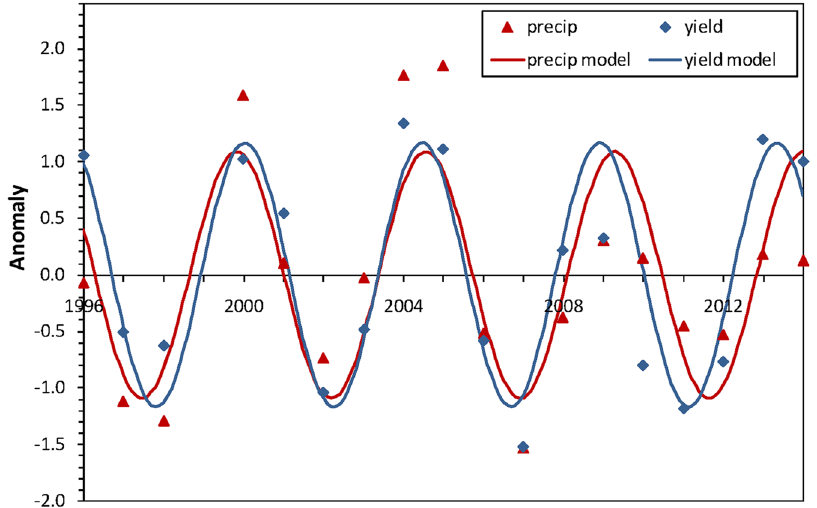
Figure 3. Periodic models of corn yield and late season precipitation anomalies. Points represent average annual anomalies for ease of visualization, but the full data set was used for analysis (n = 325 for yield and n = 328 for precipitation). Model parameter values are presented in Supplementary Table S4 for combined conventional and organic corn